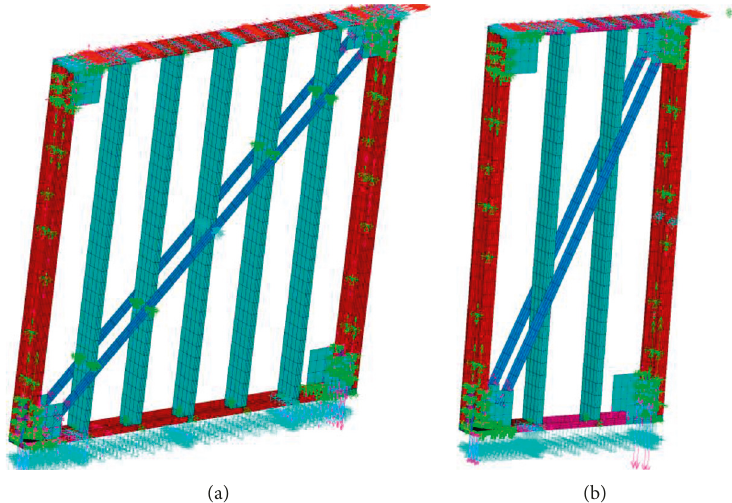
Figure 13: (a) Wall with aspect ratio 1:1 model. (b) Aspect ratio 1:2